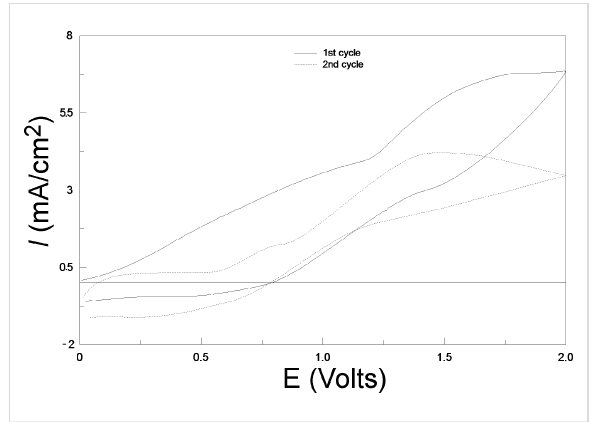
decrease in the PEDOT formation current in comparison with that obtained during the first cycle can be observed, likely due to the presence of the insulating silica sublayer.